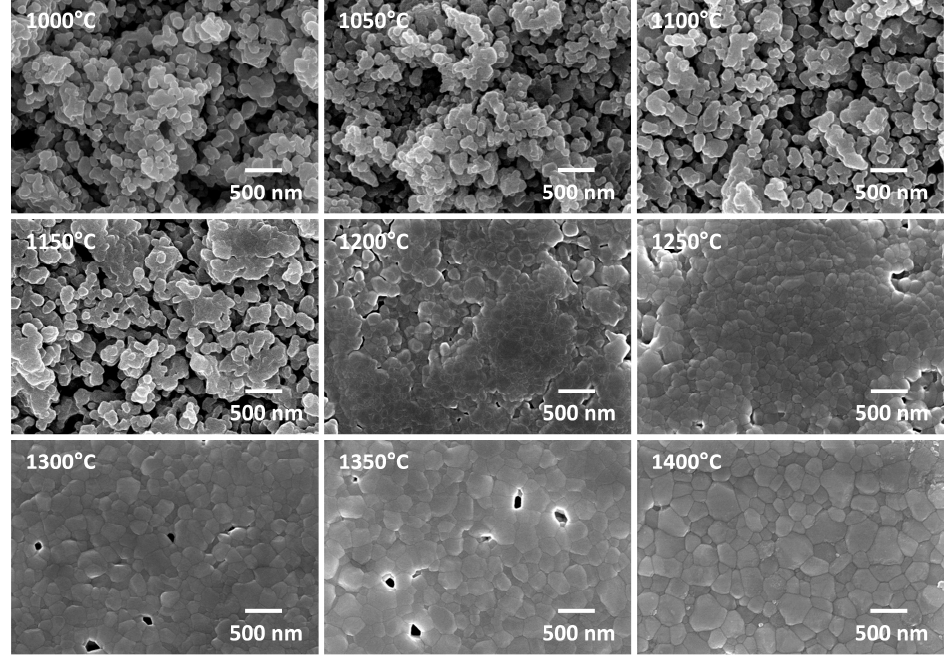
Figure 5. SEM micrographs of samples prepared from as-received powder after first step sintering. The temperatures in each label are T1.